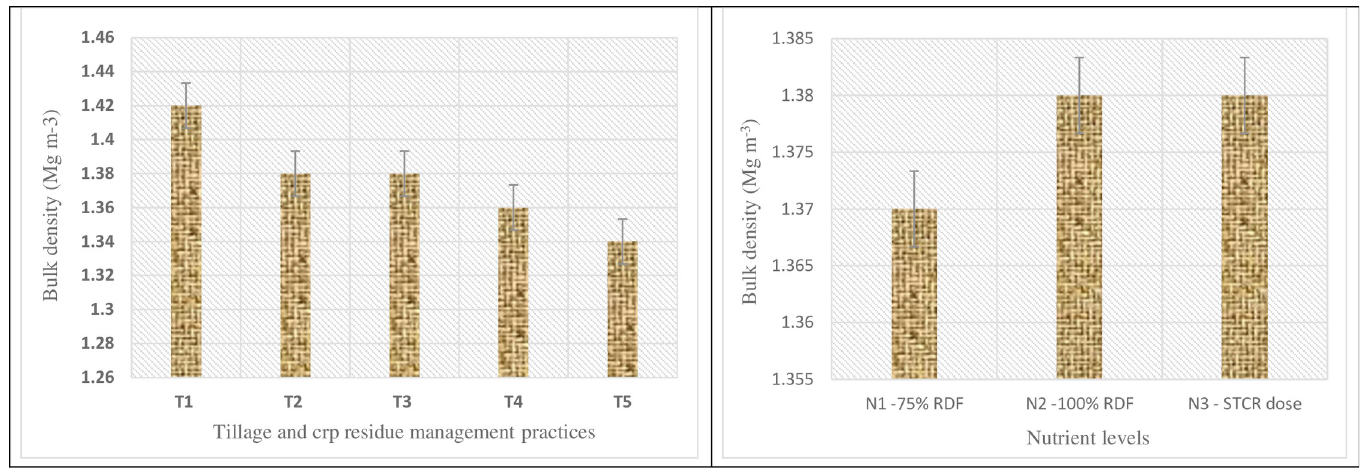
Fig 3. Effect of tillage practices, crop residue management and nutrient levels on soil bulk density. (T 1 —NT with 30cm residue height; T 2 —NT with 60cm residue height; T 3 —RT with 30cm residue height; T 4 —RT with 60cm residue height; T 5 –Conventional Tillage).